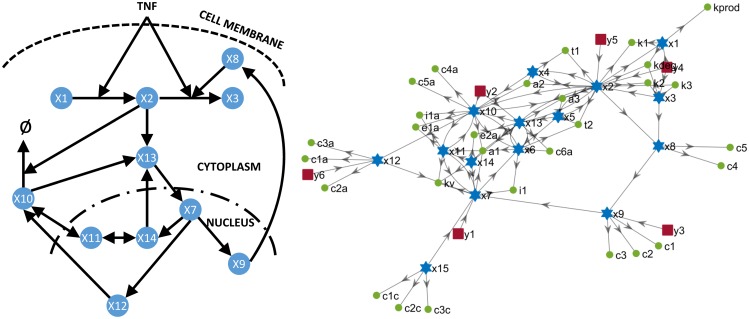
The NF-κB model.